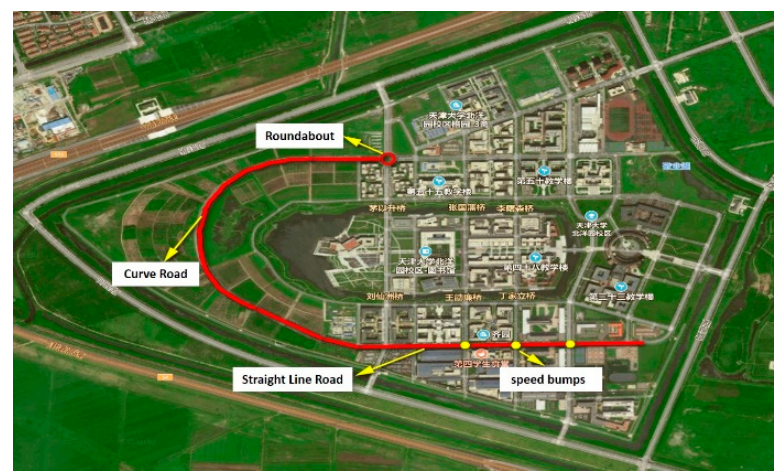
Figure 14. Autonomous driving test field at Tianjin University.